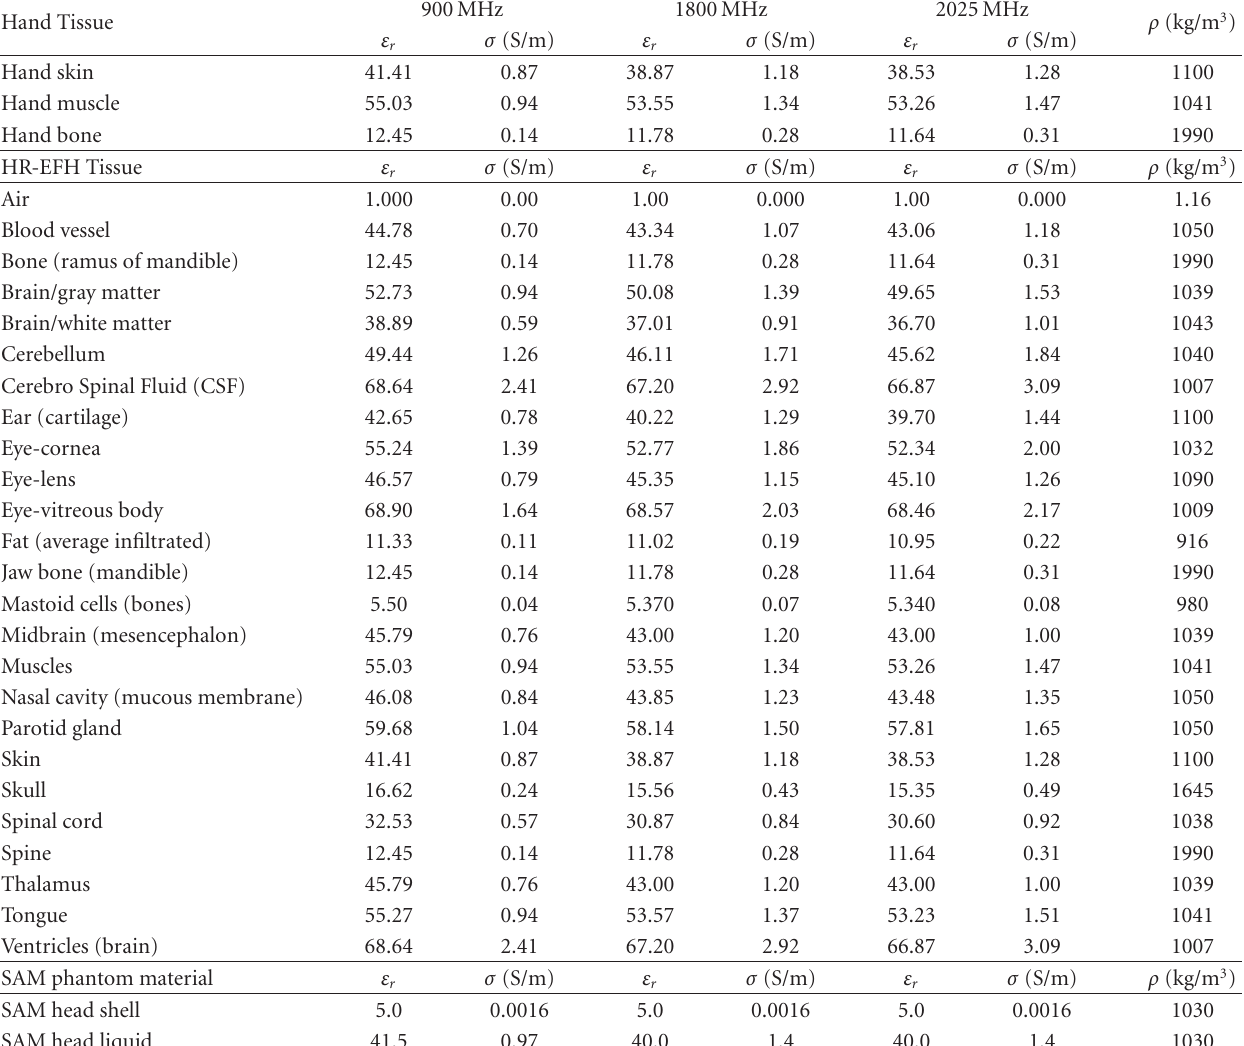
Table 2: Values of hand, HR-EFH, and SAM material parameters (relative permittivity ε r , electrical conductivity σ , density ρ ) used for simulations at 900, 1800, and